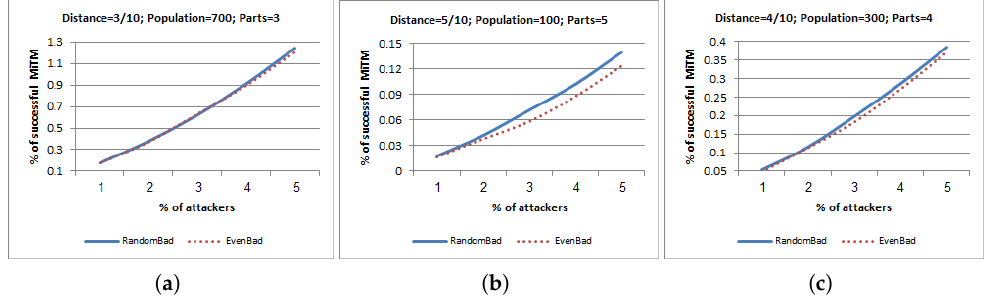
Figure 2. Fluctuating attacker as % of population. ( a ) Distance = 3/10; Population = 700; Parts = 3. ( b ) Distance = 5/10; Population = 100; Parts = 5. ( c ) Distance = 4/10; Population = 300; Parts = 4.